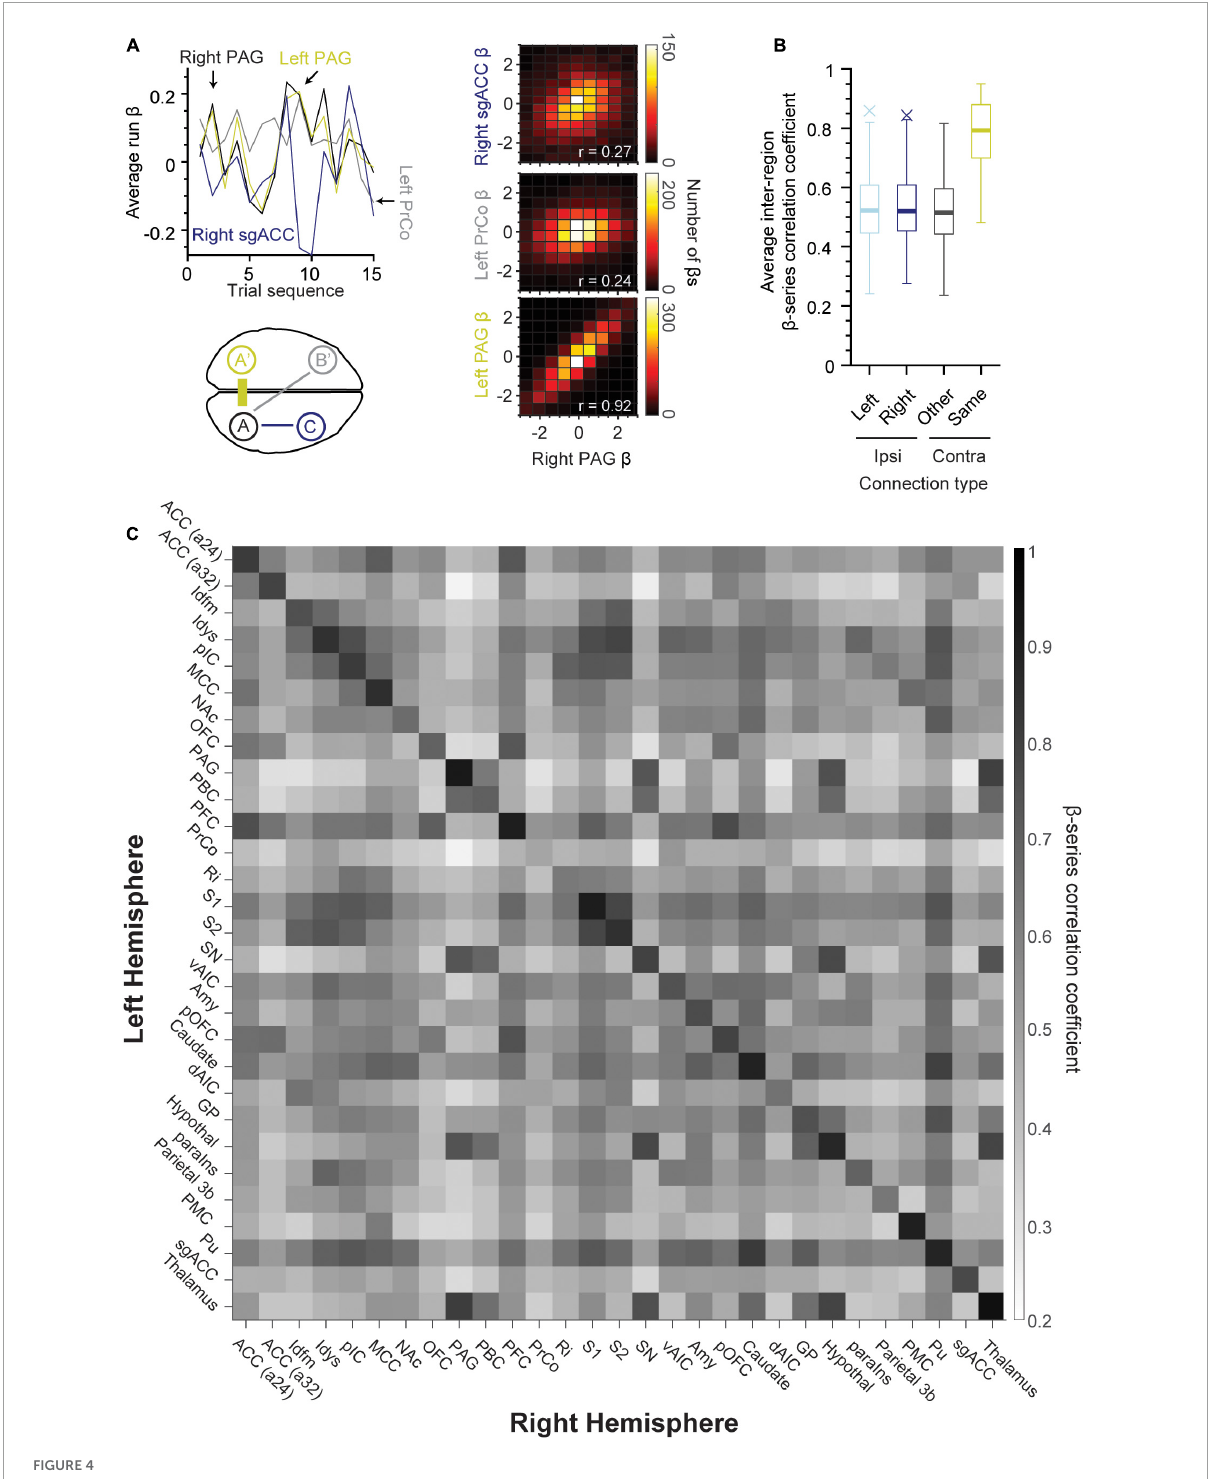
FIGURE4 Same regions across hemispheres exhibit strong connectivity during taste processing. (A) Line plot of average run β -series demonstrating correlations between right PAG (upper left panel, A, black), left PAG (A’, yellow), left PrCo (B’, gray), and right sgACC (C, blue). Lower left panel is a schematic demonstrating the approximate location of these brain regions. Note that inter-hemispheric connections were strongest for the same brain region pairs (A and A’, or right and left PAG) as compared to other contralateral and ipsilateral connections. A 2D histogram (right panels) of the β coefficients for the same region pairs (lower panel, r = 0.92, left and right PAG, middle panel, r = 0.24, left PrCo and right PAG, upper panel, r = 0.27, right PAG and sgACC). (B) Boxplot of β correlation coefficients for ipsilateral (left hemisphere: light blue, n = 406;